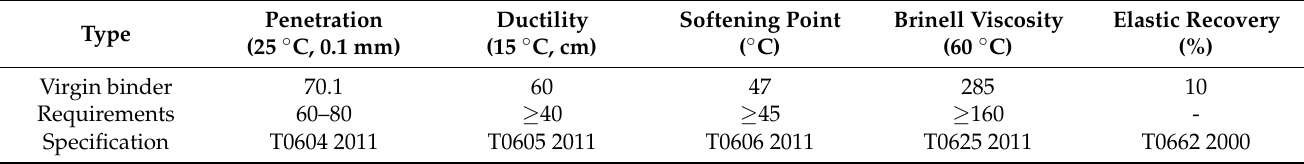
Table 2. Performances of basalt aggregates.